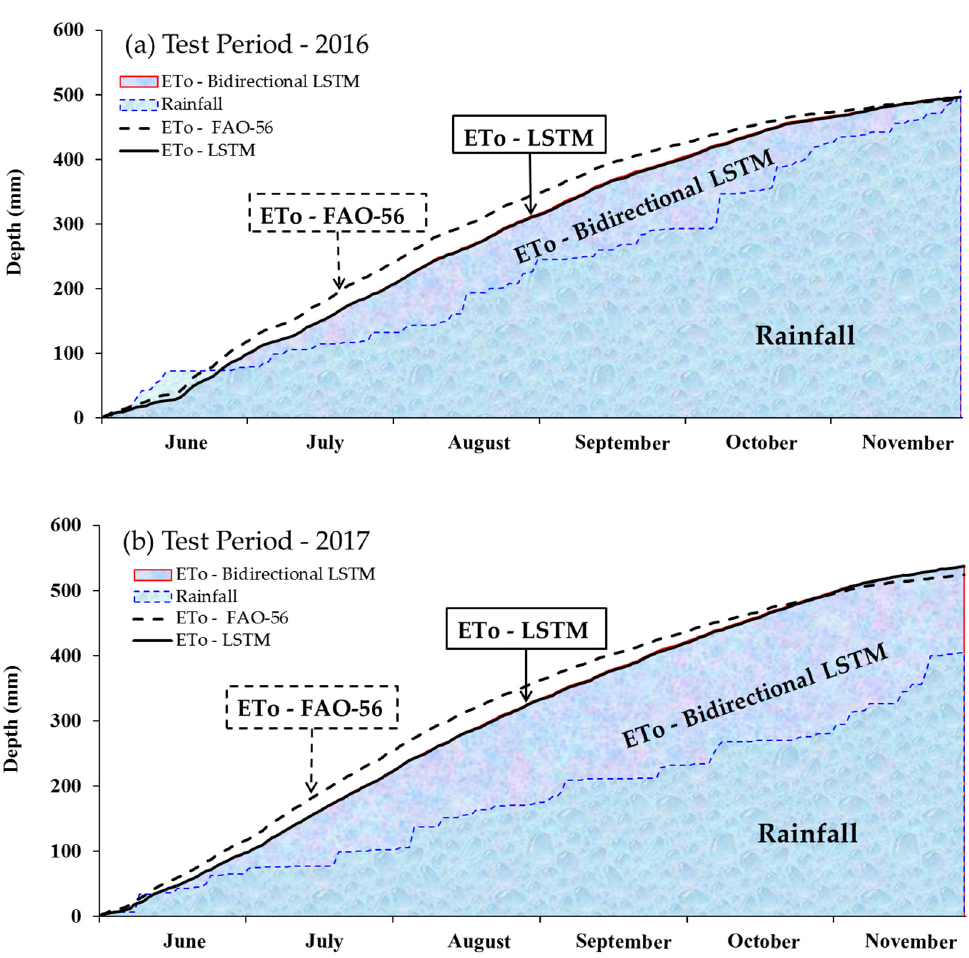
Figure 7. From bottom to top, comparison of rainfall (shown as water bubbles area chart separated from ETo-bidirectional LSTM by broken blue lines), ETo-bidirectional LSTM (shown as red vapors separated from ET O -LSTM by solid red line), ETo-LSTM (shown as solid black line), and ETo-FAO-56 (shown as broken black line) for ( a ) year 2016 and ( b ) year 2017. The curve for ETo-BLSTM is hidden under the curve of ETo-LSTM because of negligible di ff erence between the estimates of the two models. This is why ETo-BLSTM has been drawn as an area chart of red vapors above rainfall chart and ETo-LSTM is drawn as a line chart.